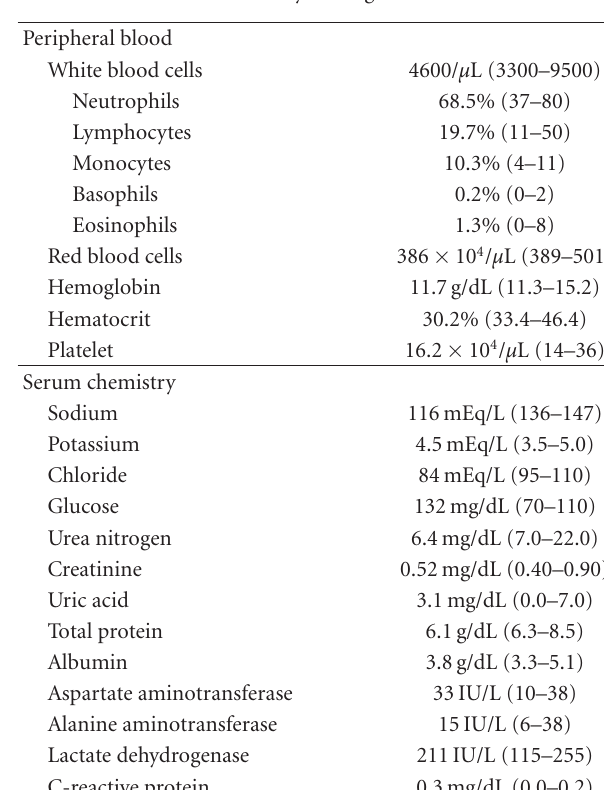
Table 1: Laboratory findings on